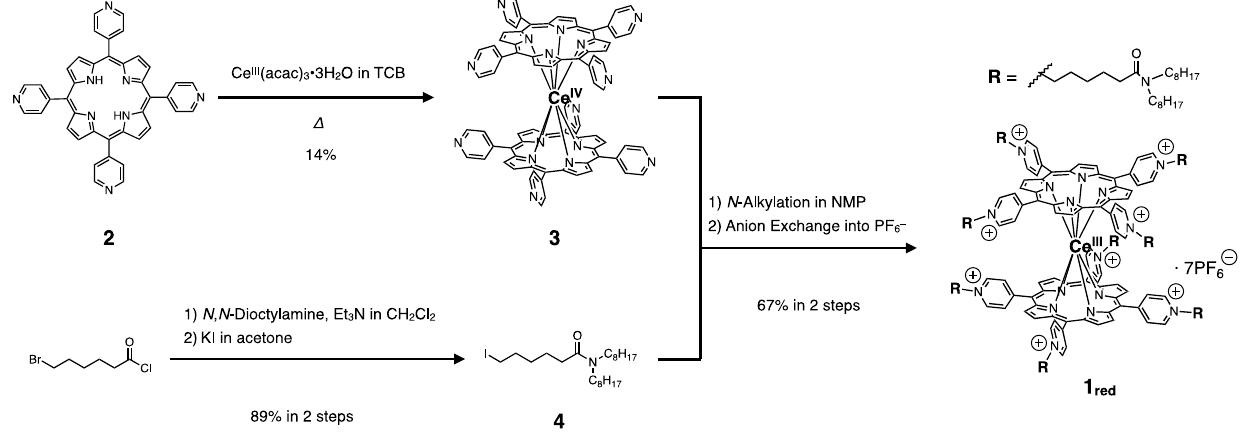
Scheme 1. Synthesis of reduced complex 1 red